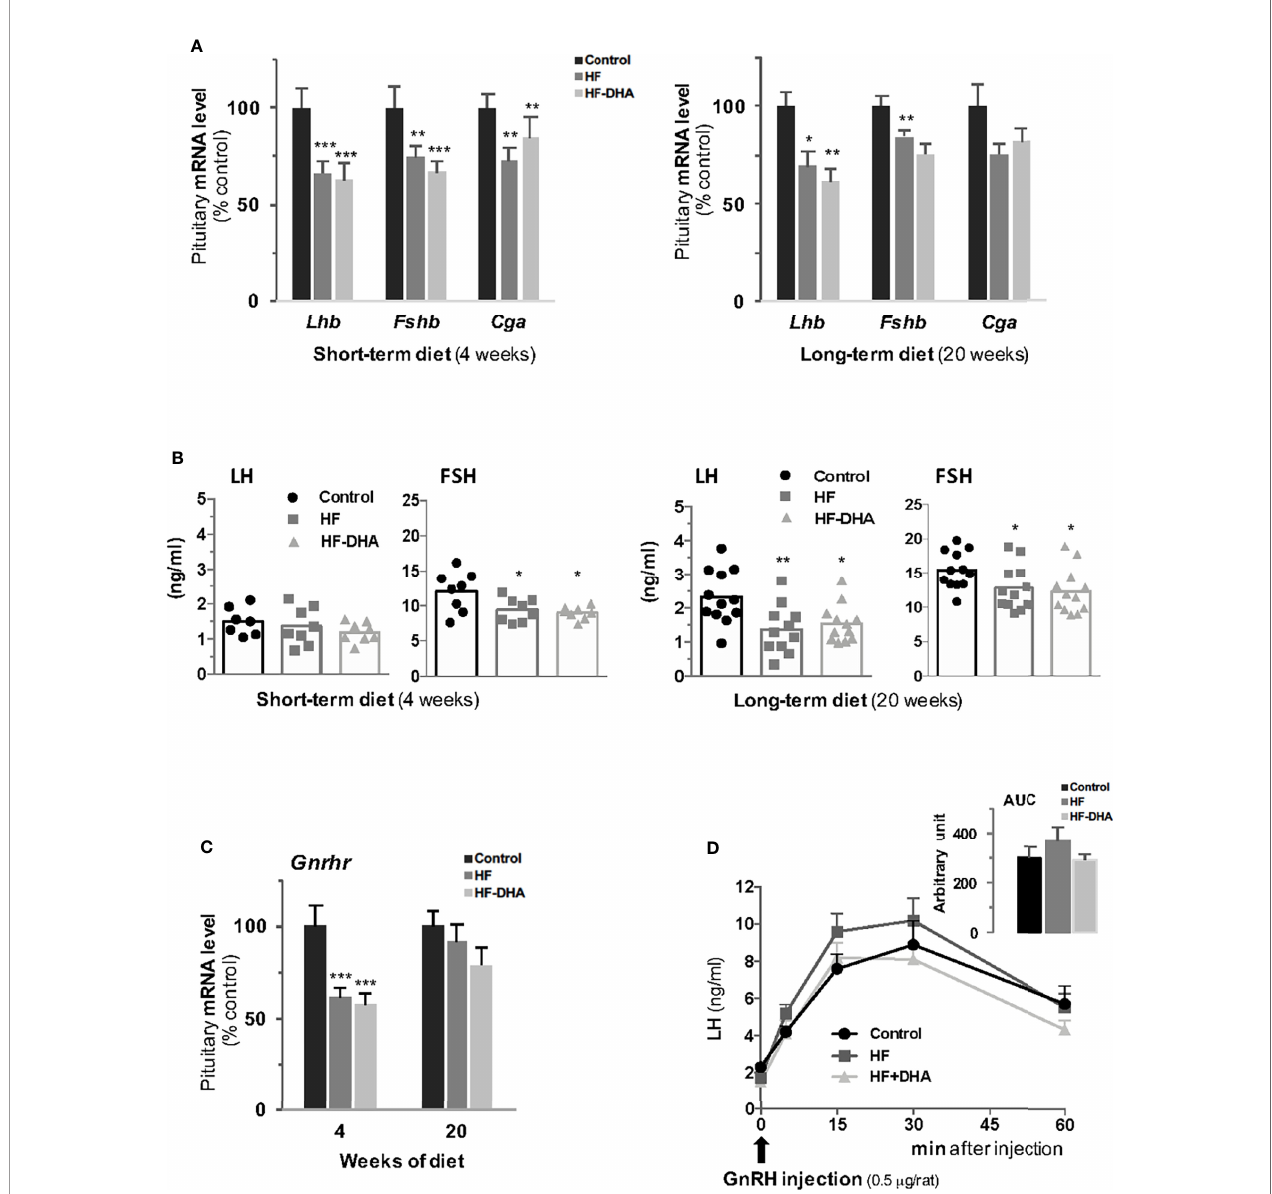
FIGURE 6 | Characterization of pituitary gonadotrope function in rats after short-term or long-term high-fat diets. (A) Transcript levels of gonadotropin subunits, Lhb , Fshb and Cga , were measured in pituitaries of rats fed control, HF or HF-DHA diets for 4 or 20 weeks. Transcript levels were determined and expressed as indicated in Figure 2 . (B) The levels of the two circulating gonadotropins, LH and FSH, were simultaneously measured in sera using Luminex technology after 4 and 20 weeks of diet. The bar height re fl ects the mean. (C) Transcript levels of Gnrhr in control rats or rats fed high-fat diets for 4 and 20 weeks. (D) Pituitary GnRH receptivity in control rats or rats fed high-fat diets for 15 weeks. The natural agonist GnRH (0.5 m g/rat; Sigma LHRH, L 7134, St-Quentin Fallavier, France) was subcutaneously injected and tail blood was collected 0, 5, 15, 30 and 60 min later for LH level determination. The AUC (Area Under the Curve) was calculated for the three groups of rats and no statistical difference was observed. Data are from 6-8 rats in panels A, C and D and from 7-8 (short-term diets) or 11-12 (long-term diets) rats in panel (B) Data are expressed as means ± SEM and analyzed with one-way ANOVA followed by Tukey ’ s multiple comparison test. * P ≤ 0.05; ** P ≤ 0.01; *** P ≤ 0.001 compared to control